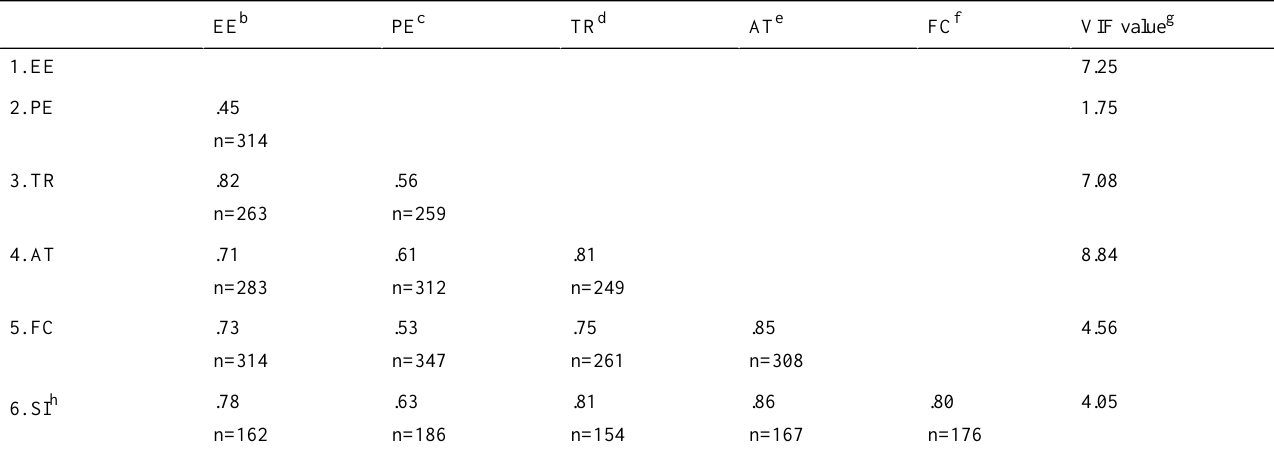
Table 2. Matrix of linear correlations and variance inflation factor values between the independent constructs that could influence intention to use Internet appointment planning.